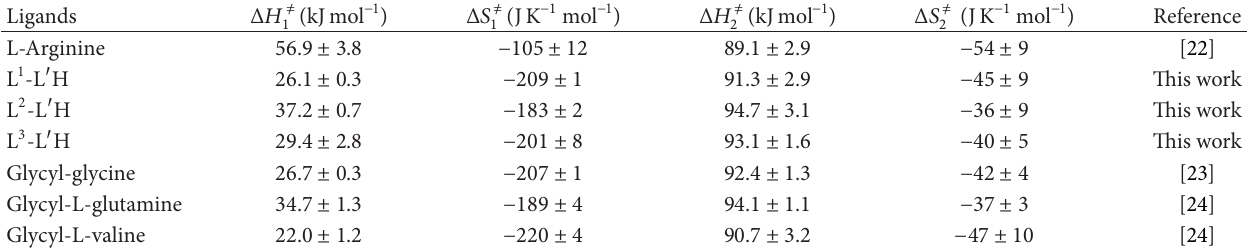
Table 4: Comparison of activation parameters for the interaction of different ligands with the complex in aqueous medium at pH = 4.3.